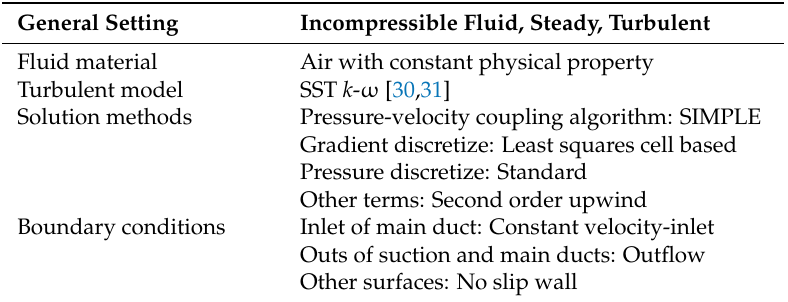
Figure 7. Comparisons between CFD results with experimental measurements. ( a ) With vanes, R = 0.150, ϕ = 90 ◦ ; ( b ) and ( c ) Without vanes, R = 0.117 and R = 0.150 and 0.263. Table 2. Detail settings in three-dimensional CFD